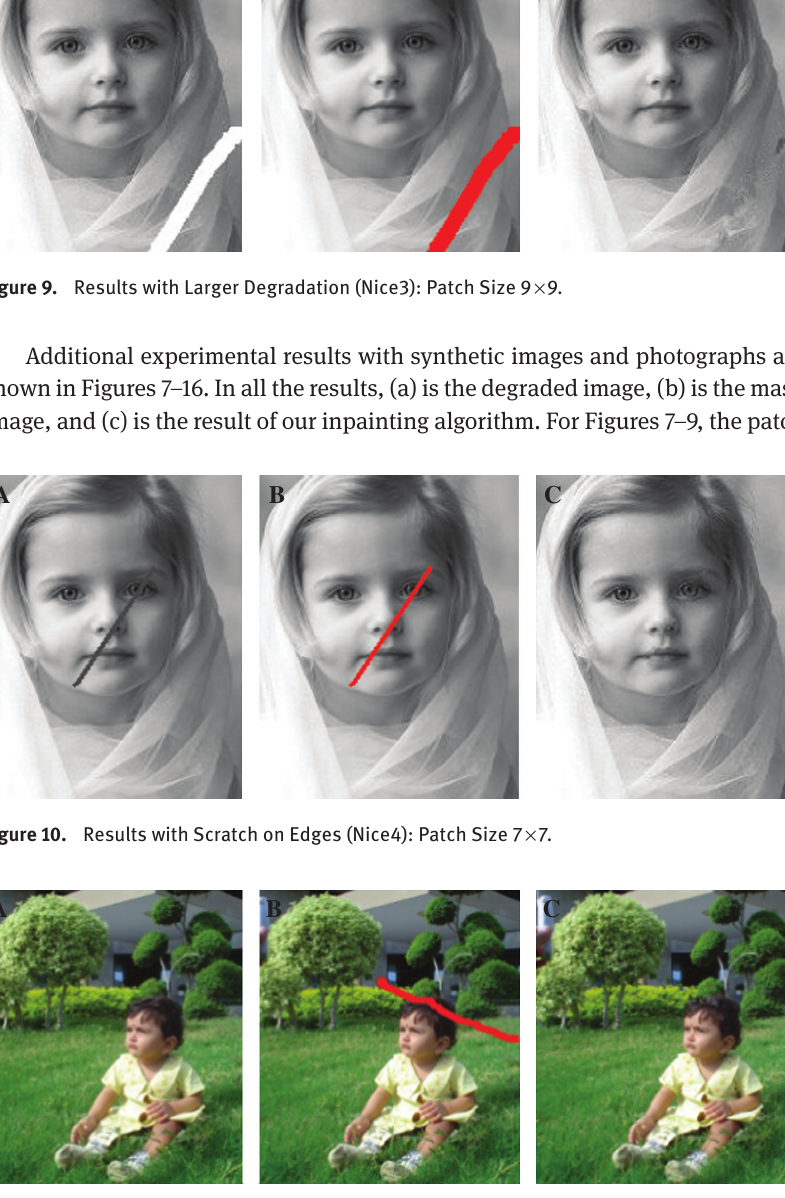
Figure 11. The Child Image Reconstruction: Patch Size 7 × 7.